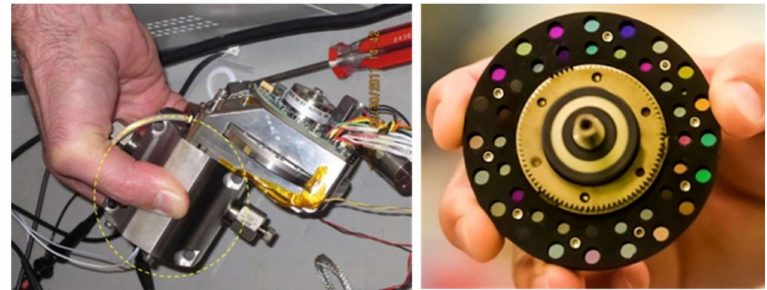
Figure 1. Multivariate optical computing (MOC) sensor body ( left ) and close up of multichannel wheel ( right